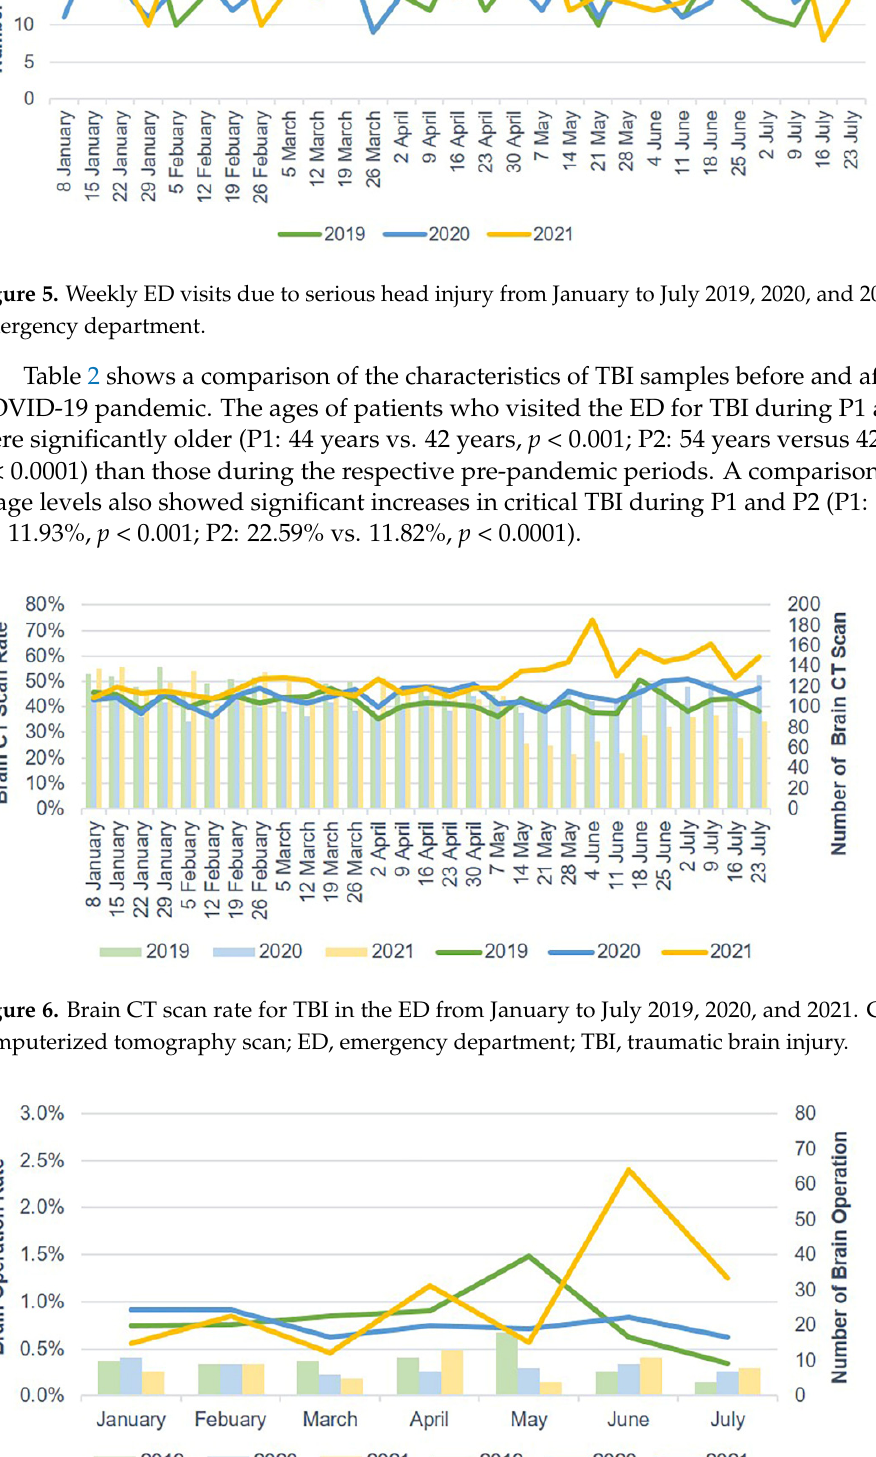
Figure 4. Weekly ED visits due to mild head injury from January to July 2019, 2020, and 2021. ED, emergency department.